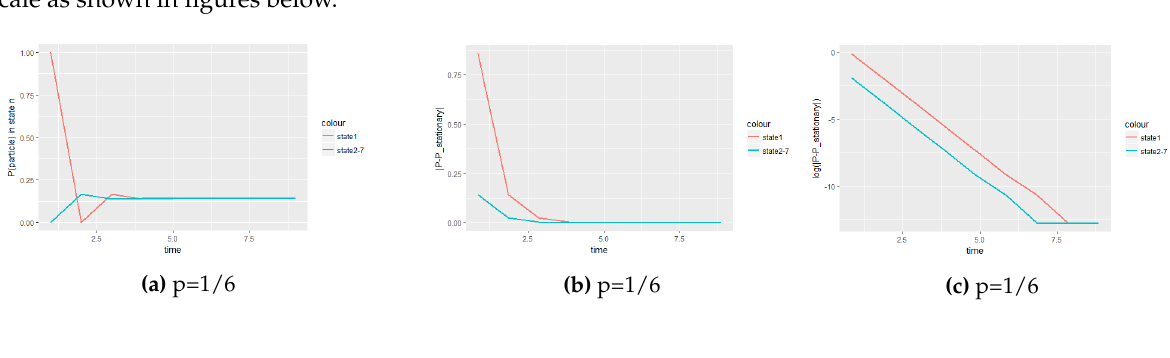
Figure 6. A panel of graphs to show how fast the equilibrium is attained in log scale under hexagonal tiling when the particle is initially at the central cell with probability vector v = ( 1,0,0,0,0,0,0 ) .